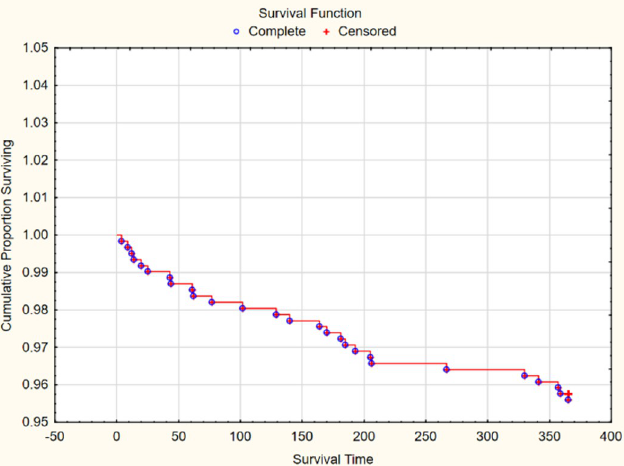
Fig 1. Kaplan Meier curve showing the proportion of study participants surviving from index visit (day 0) to 1 year (day 365).